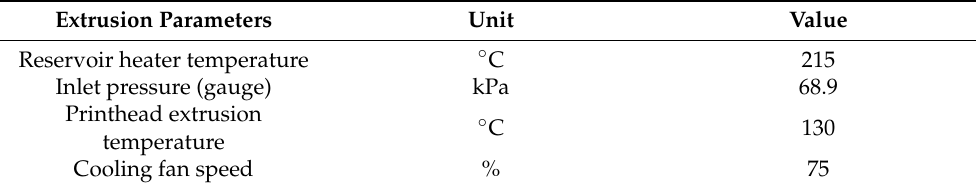
Table 4. Key process parameters in artificial muscle